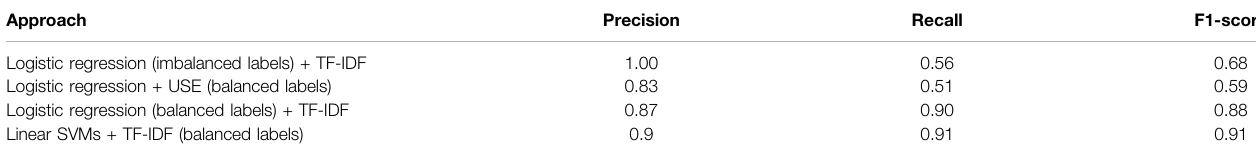
TABLE 3| Results ofclassi fi cation withlogisticregressionandSVMsusingdifferentfeaturesevaluatedusing10-foldcrossvalidationofthetrainingdatawithheuristiclabels. Approach Precision Logistic regression (imbalanced labels) +